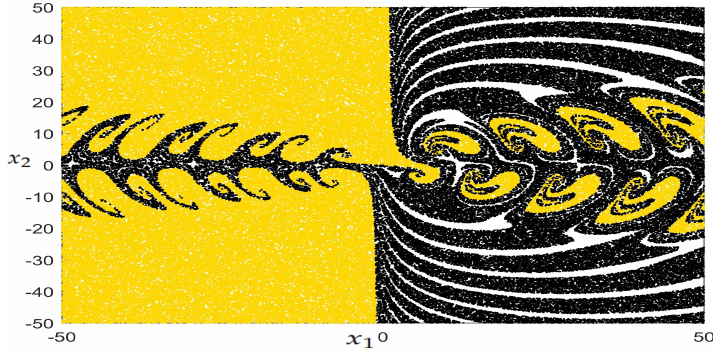
Figure 2. Two-dimensional cross-section of basin of attraction at x 3 = 0 for b 22 = 3.9 based on discrete points with the aid of